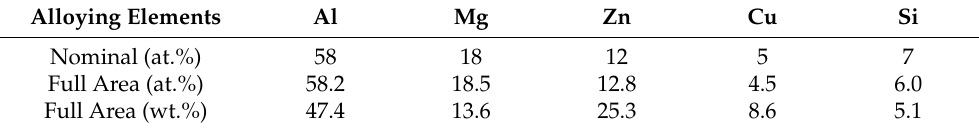
Table 4. Elemental composition of the manufactured alloy in 1M specimen obtained by EDS. Alloying